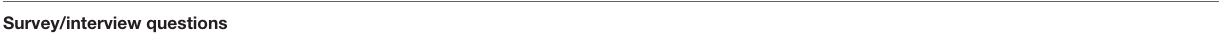
TABLE 1 | Survey/interview